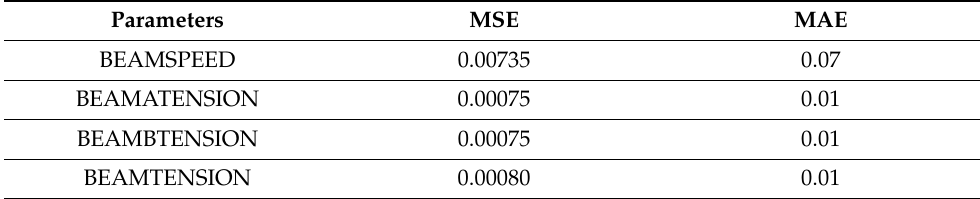
Table 17. Ridge regression results for the beaming process.